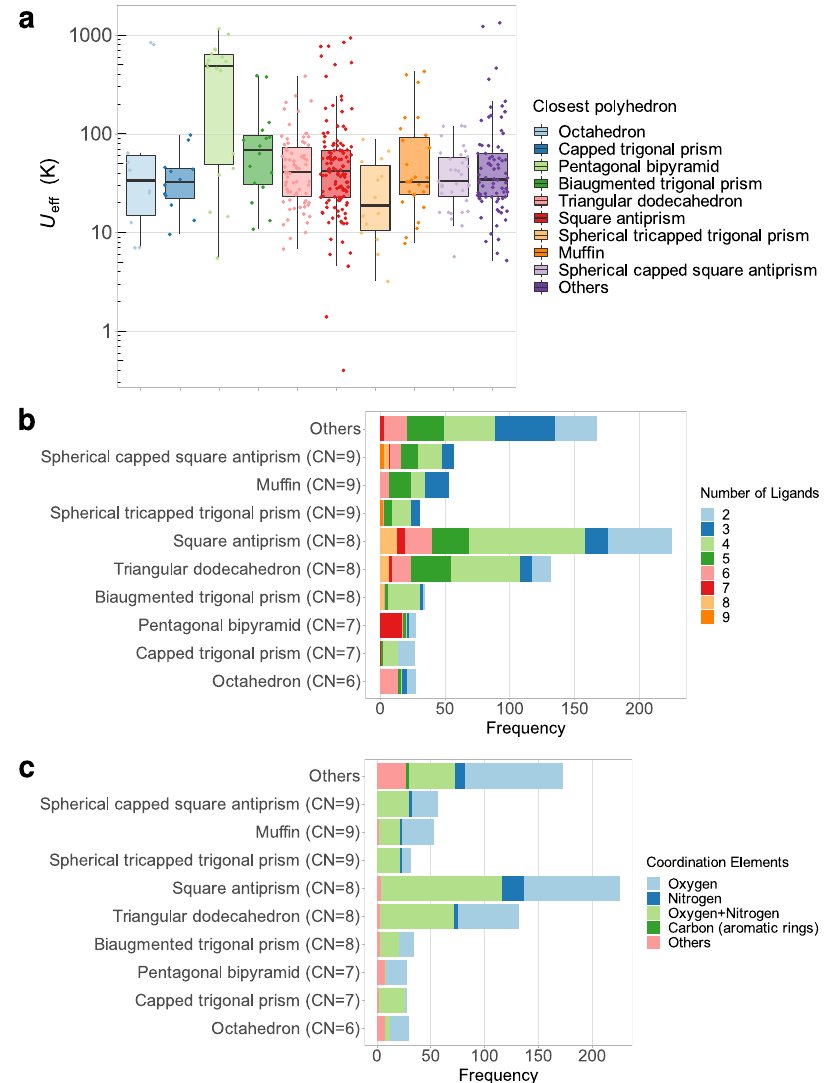
Fig. 6 | Relation between U eff and chemical design. a Dependence between U eff and coordination polyhedra. b Numbers of ligands that are present in the different coordination polyhedra. c Elements in the coordination sphere that are present in the different coordination